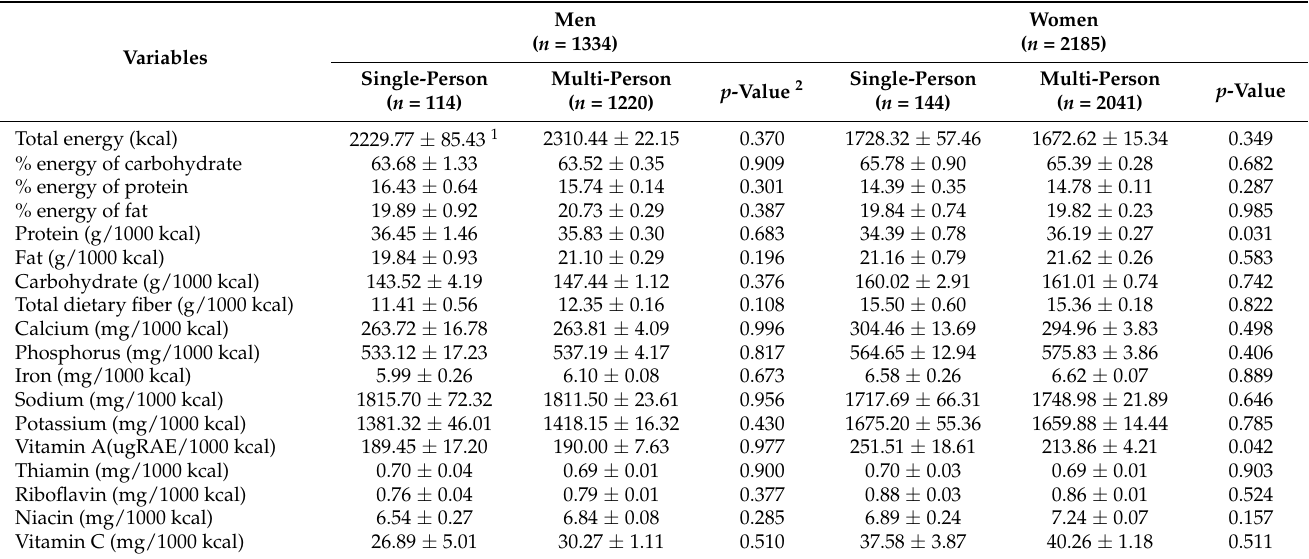
Table 3. Participants’ nutrient intake according to household size by sex.